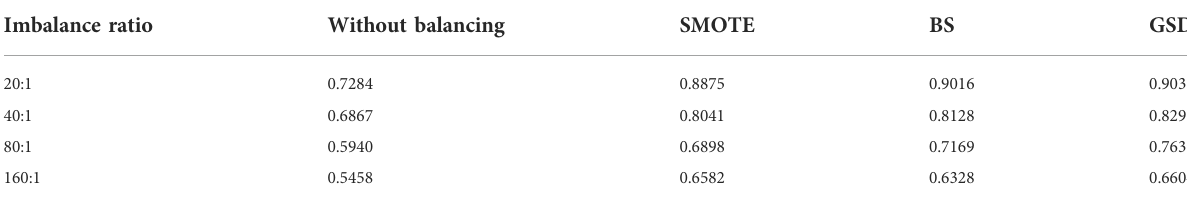
TABLE 4 lassi fi cation accuracy based on different imbalance